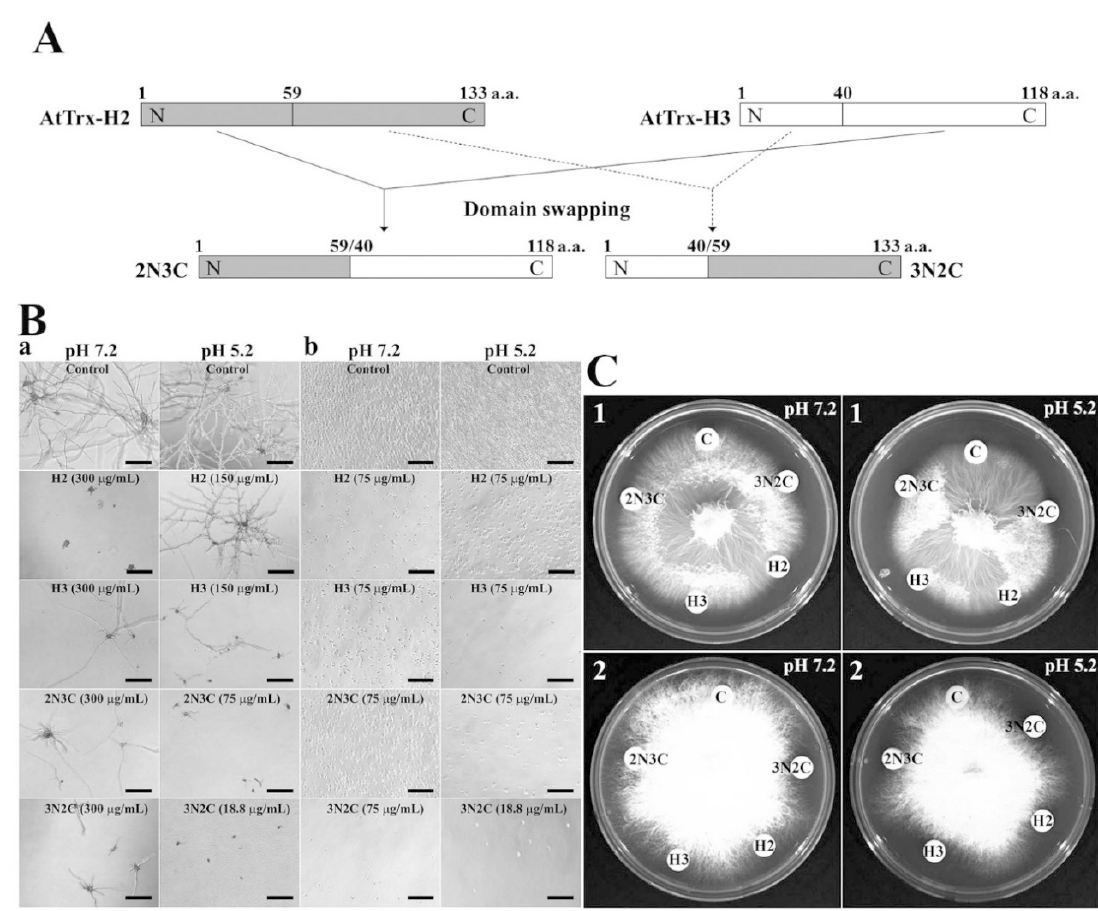
Figure 1. Growth inhibition of Trx-H2, -H3, -2N3C, and -3N2C proteins in liquid ( B ) and solid ( C ) cultivation. ( A ) Schematic representation of domain swapping between AtTrx-H2 and -H3. a: F. solani , b: C. albicans , 1: F. moniliform , 2: T. ruburum .